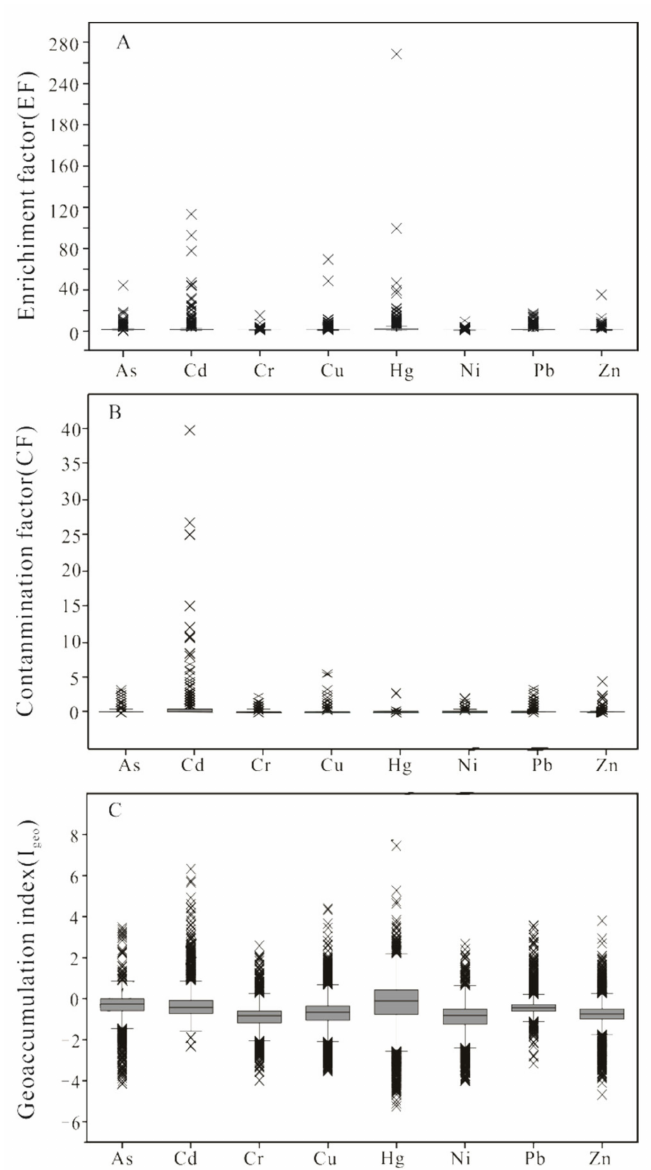
Figure 6. Box-plots display the distributions of the pollution indexes of heavy metals in surface soils of the study area. ( A ) enrichment factor (EF); ( B ) contamination factor (CF); ( C ) geo-accumulation